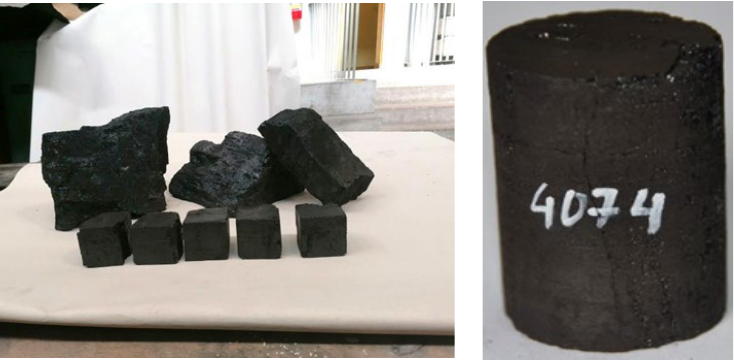
Figure 3. Irregular coal specimens collected from workings and regular laboratory specimens (cubic and cylindrical) before and cylindrical) before testing.